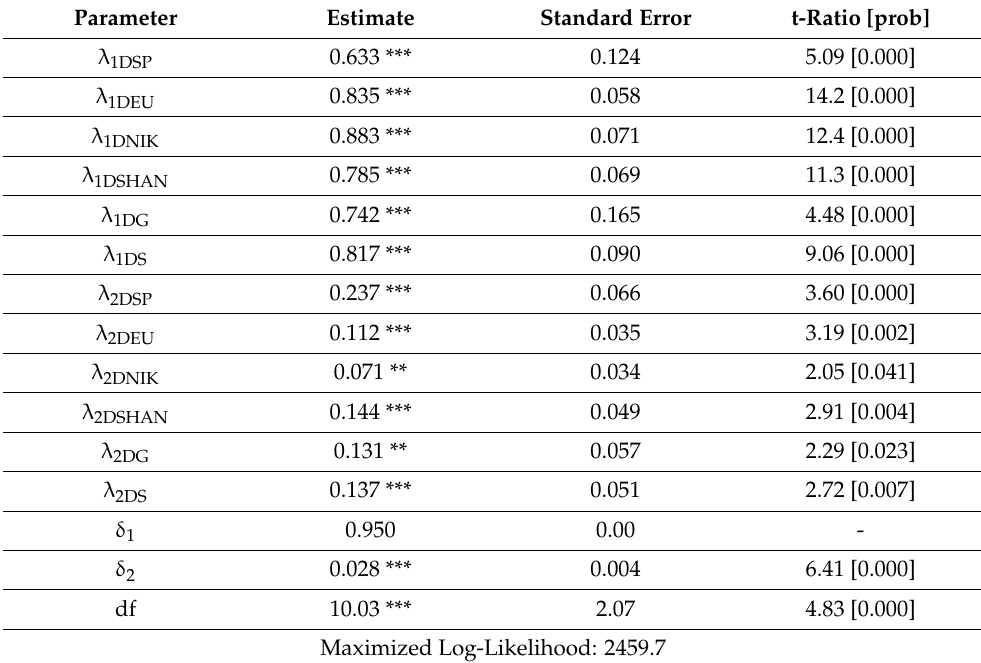
Table 3. Multivariate Garch (1, 1) t-DCC Model. Sample: 2000M11–2019M10 (221 Obs.). Parameter Estimate Standard